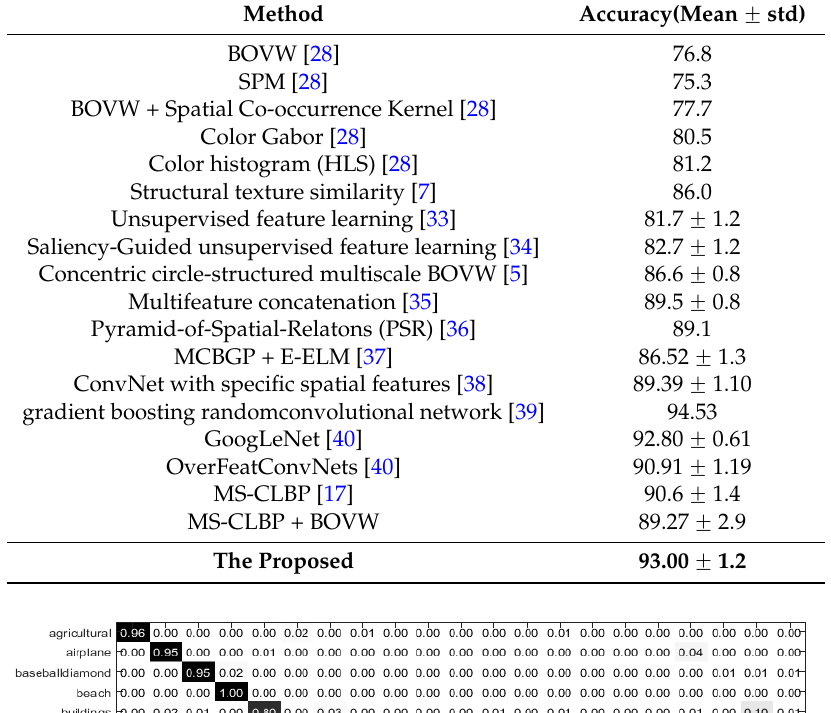
Table 1. Comparison of classification accuracy (%) forthe 21-class land-use dataset.